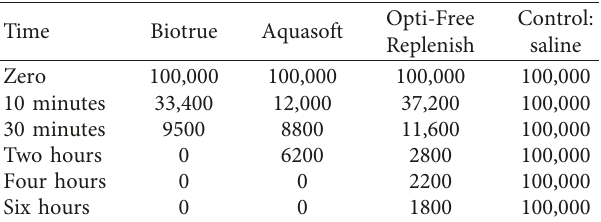
Table 1: Colony counts per solution per time interval for Staph- ylococcus aureus .